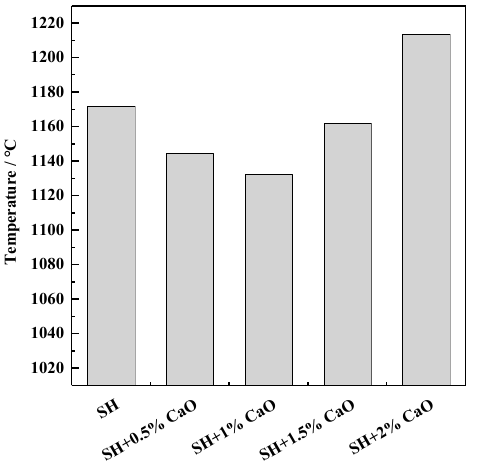
Figure 3. The influence of the addition of CaO on the softening temperature of coal ash.